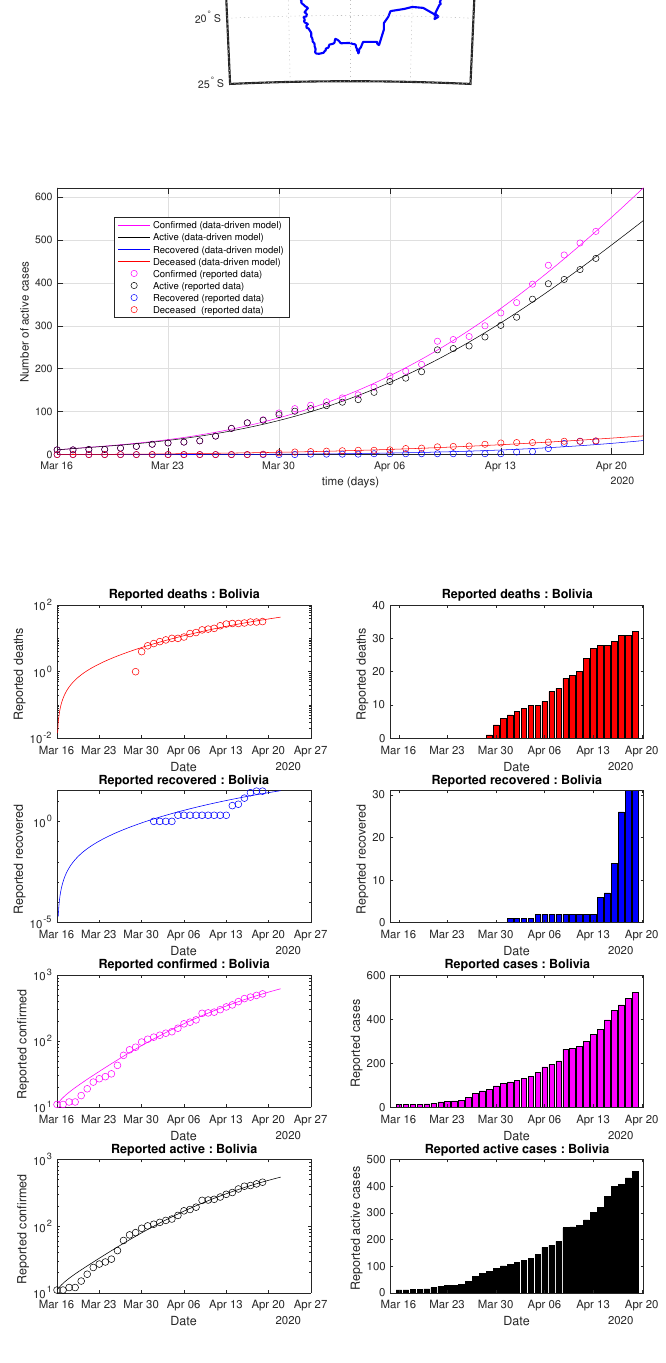
Figure 21. Bolivia: data of active, recovered, deceased (in circle or bar) vs. model of active, recovered, deceased over time. Tracking the number of active cases. Predictive analytics for the next couple